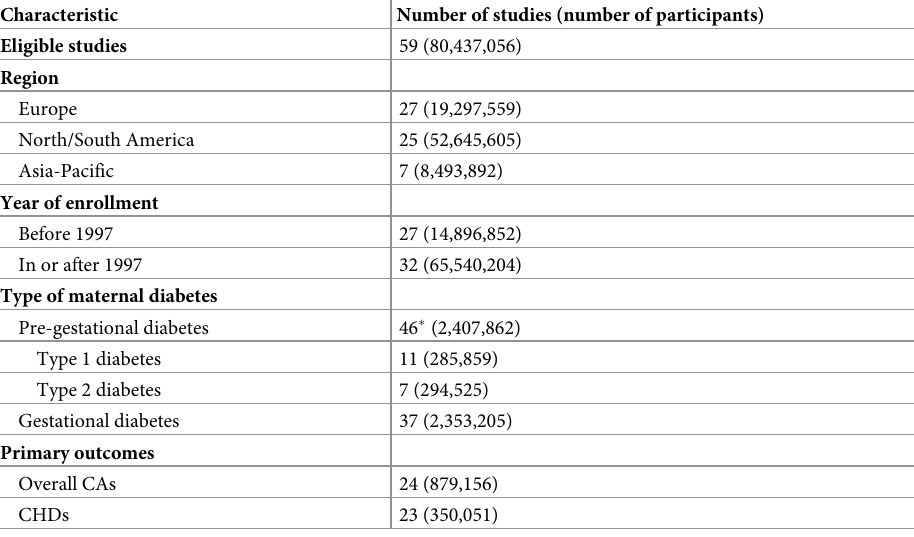
Table 1. Summary characteristics of included